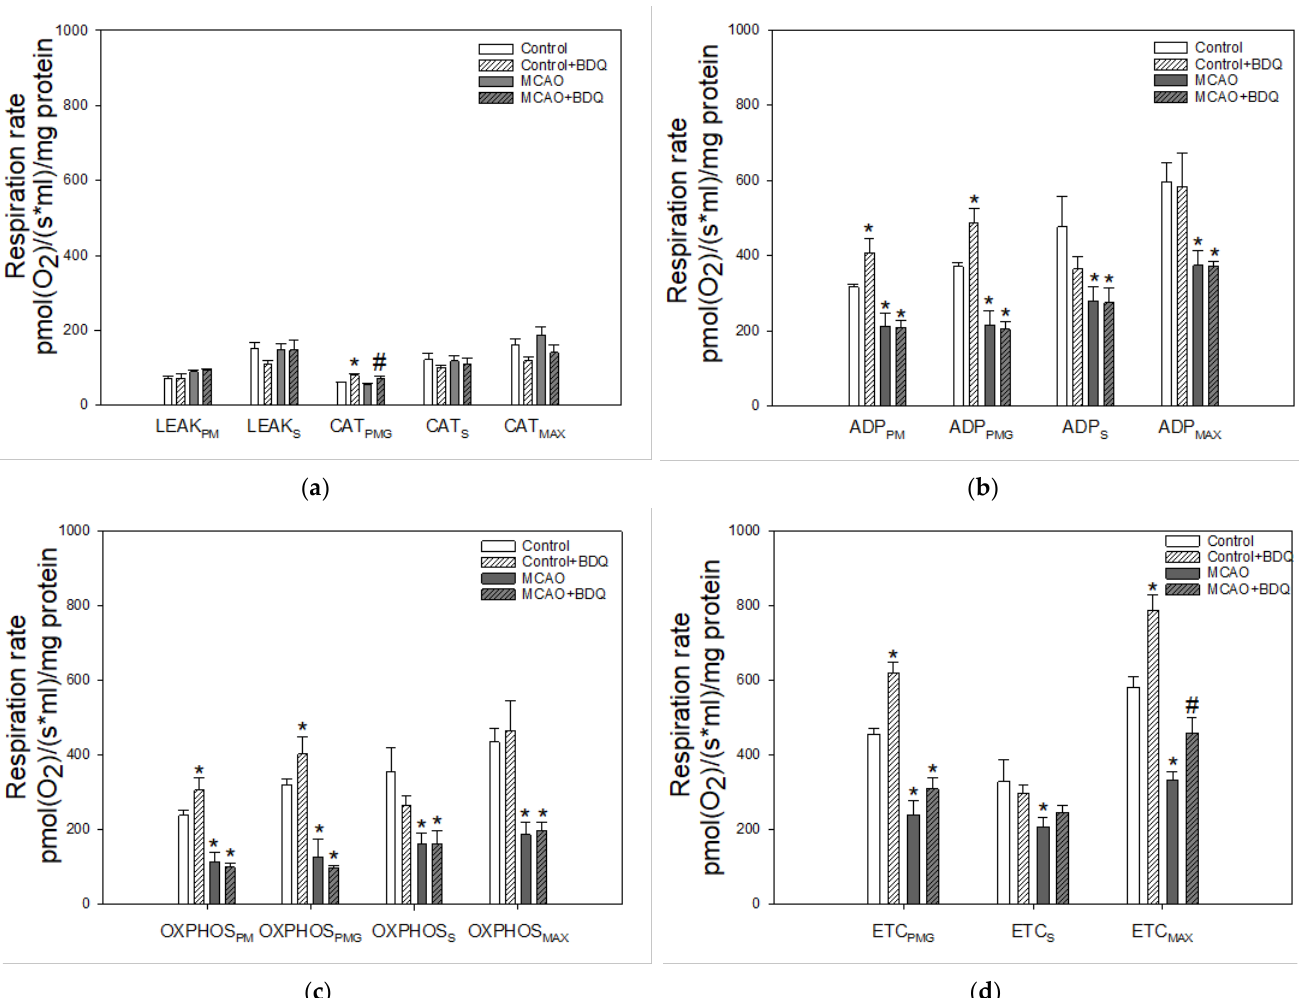
Figure 2. Mitochondrial respiration rates after MCAO and BDQ treatment. ( a )—Oxygen consumption rates (OCRs) in the proton leak linked respiration states with complex I (LEAK PM and CAT PMG ), complex II (LEAK S and CAT S ), and complex I +II (CAT MAX ) substrates; ( b )—OCRs in the ADP-stimulated respiration states with complex I (ADP PM and ADP PMG ), complex II (ADP S ), and complex I +II (ADP MAX ) substrates; ( c )—calculated values of OCRs linked to oxidative phosphorylation (identical metabolic states to Figure 3b; ( d )—OCRs linked to maximal electron transport chain (ETC) capacities with complex I (ETC PMG ), complex II (ETC S ), and complex I +II (ETC MAX ) substrates. LEAK refers to a metabolic state in which mitochondria and substrates are added to the reaction chamber without ADP; CAT refers to a metabolic state induced by the addition of 2μM carboxyatractyloside (CAT); ADP refers to a metabolic state in which mitochondria, substrates, and ADP are present; OXPHOS refers to a calculated value representing OCRs strictly linked to oxidative phosphorylation; ETC refers to the OCRs of uncoupled mitochondria. The substrates are abbreviated: P—pyruvate; M—malate; G—glutamate; S—succinate; MAX—all of the listed substrates. Data are presented as Mean ± SEM of 6–7 experiments on individual animals. Statistically significant difference ( p < 0.05): *—compared to control; #—compared to MCAO.